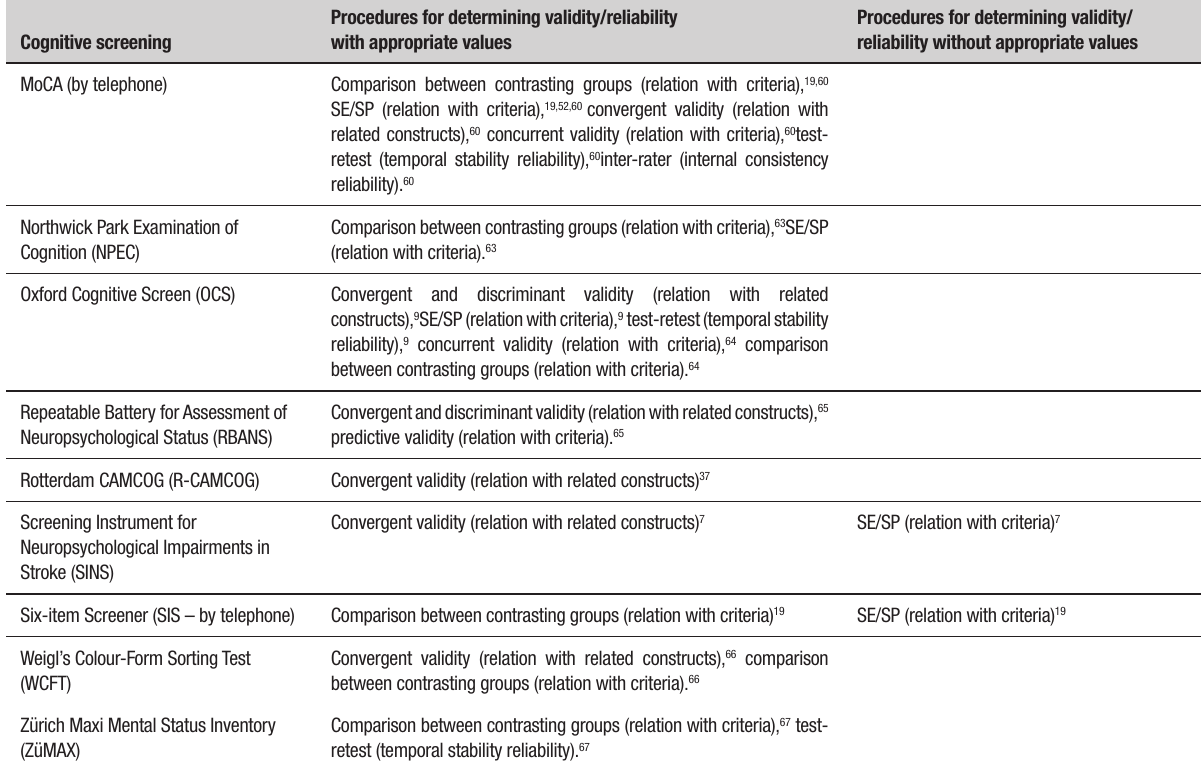
Table 2. Cognitive screenings,procedures for determining validity/reliability (continuation). Procedures for determining validity/reliability Cognitive screening with appropriate values